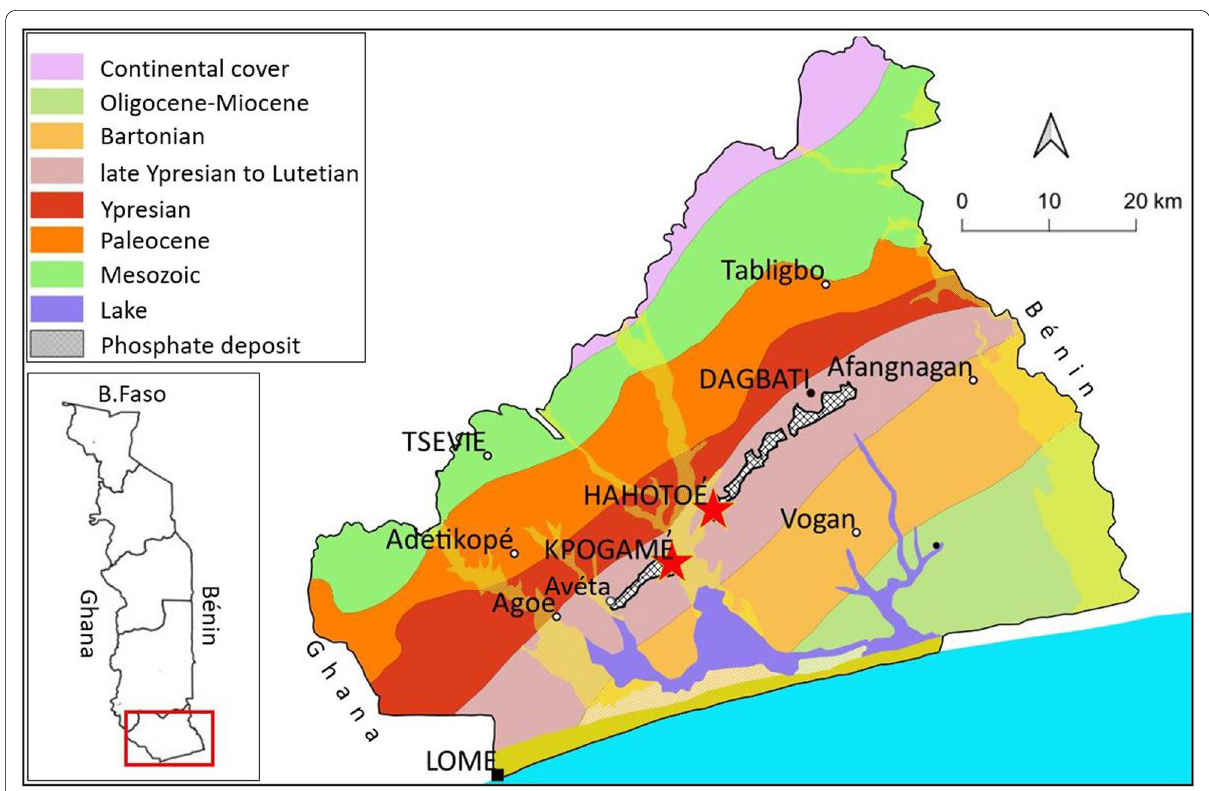
Fig. 1 Geological map of Togo indicating the fossil quarry of